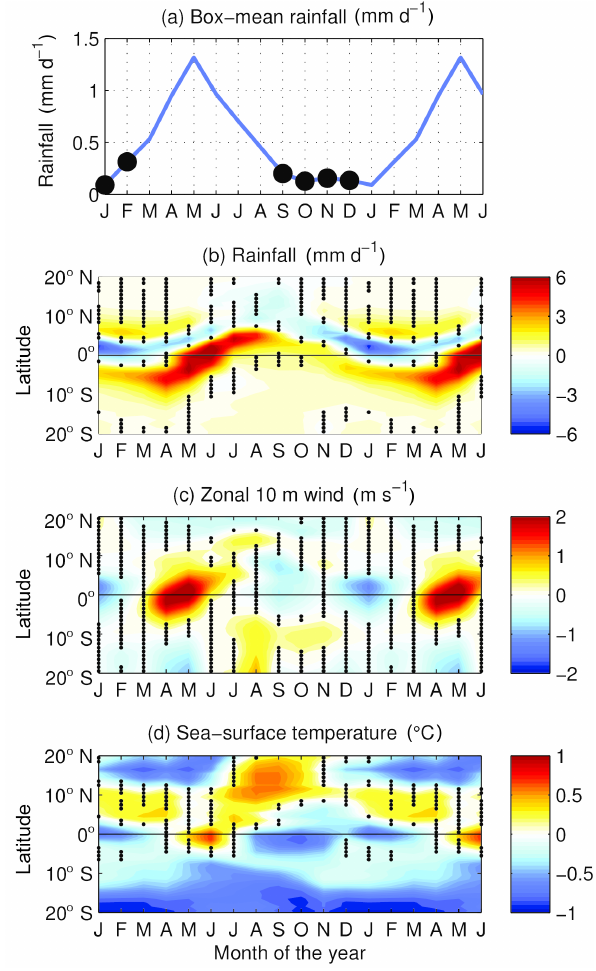
Figure 2. Seasonal cycle of biases in the tropical Atlantic. All biases are calculated for the seventh month of hindcast. Panel (a) shows the bias in box-mean rainfall in the range 40–0 ◦ W and 20 ◦ N–20 ◦ S; the other panels show latitude–time plots of zonal mean biases in the same longitude range for (b) rainfall, (c) zonal wind at 10m and (d) sea-surface temperature. Insignificant regions of each plot with respect to interannual variability are indicated with black